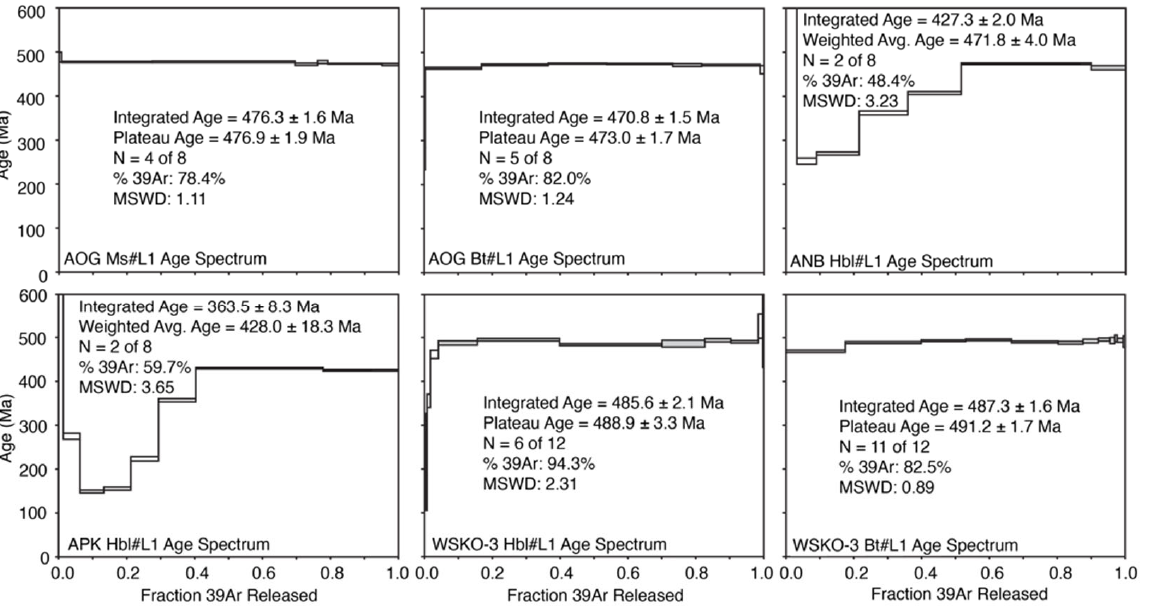
Figure 5. 40 Ar/ 39 Ar incremental release spectra for hornblende (Hbl), muscovite (Ms), and biotite (Bt) mineral separates from metasedimentary rocks samples from the Duncan Mountains and Mount Wasko. Vertical axes represent age (Ma), and horizontal axes represent cumulative percent of 39 Ar released. Ages in the fi gure are reported at the ±1-sigma level but are reported at the ±2-sigma level in the text for the sake of comparison to other geochronological constraints. Steps fi lled in grey were used for plateau and weighted average age determinations.